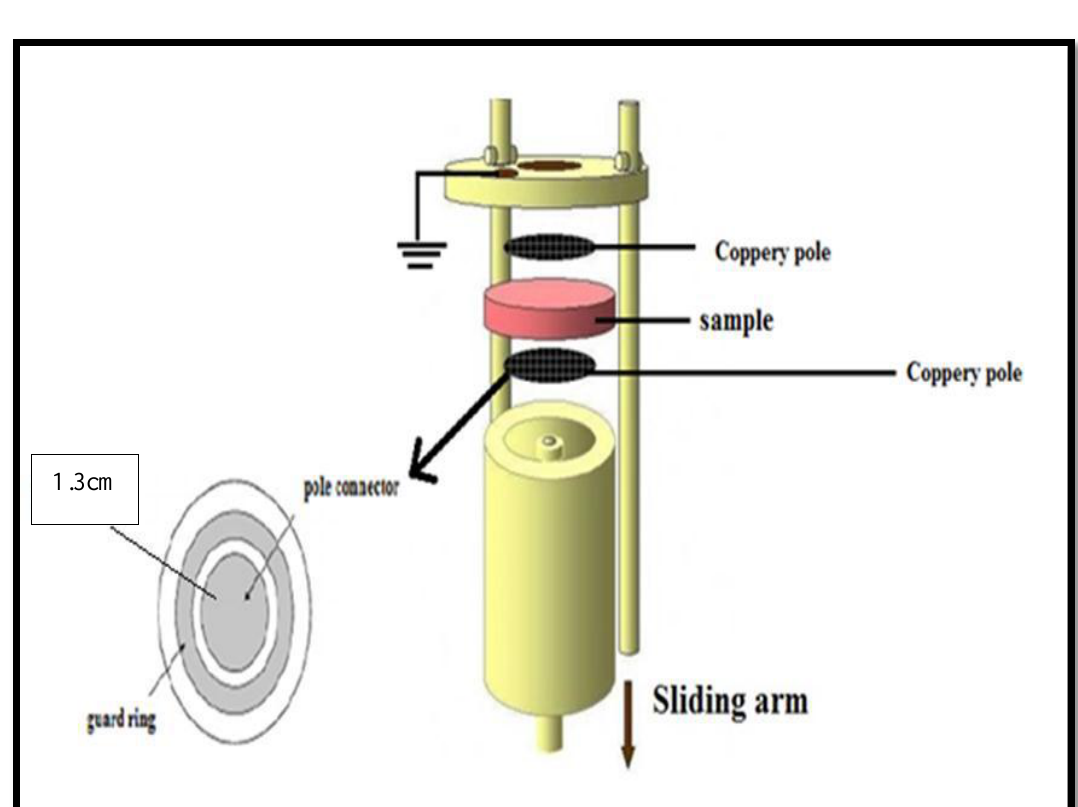
Fig.5: Schematic diagram of used